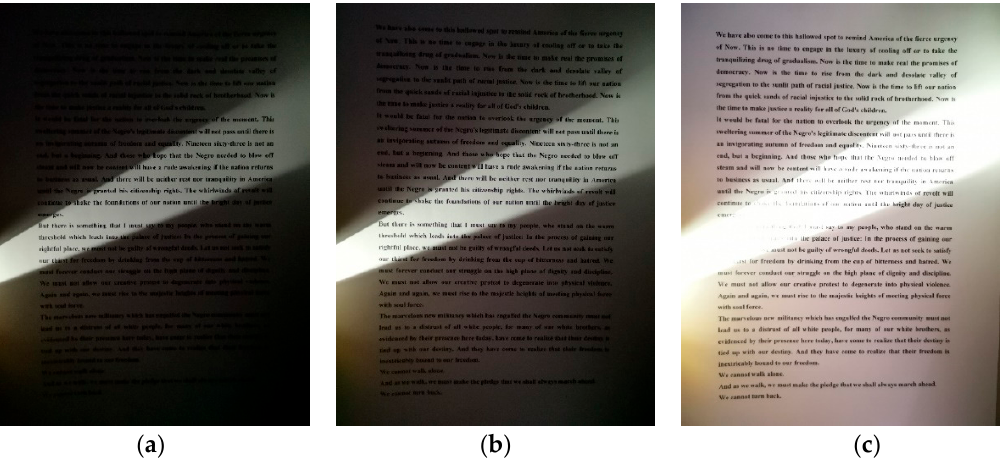
Figure 1. Camera document images with different exposure times. ( a ) exposure time: 1/800 s (under-exposed). ( b ) exposure time: 1/320 s (well-exposed). ( c ) exposure time: 1/40 s (over-exposed).